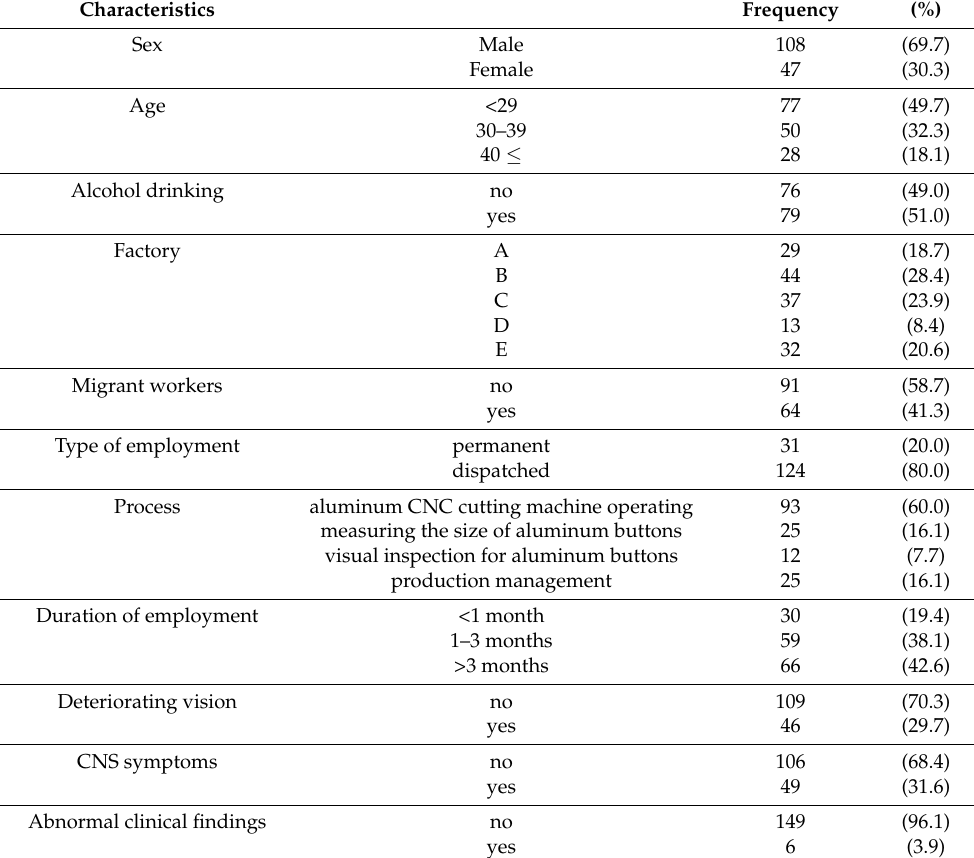
Table 1. Characteristics of co-workers of methanol poisoning cases ( n = 155). Unit: